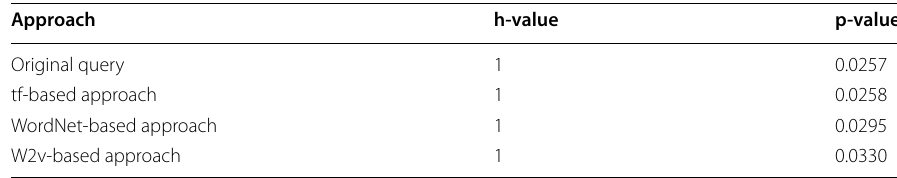
Table 9 Paired t‑test results